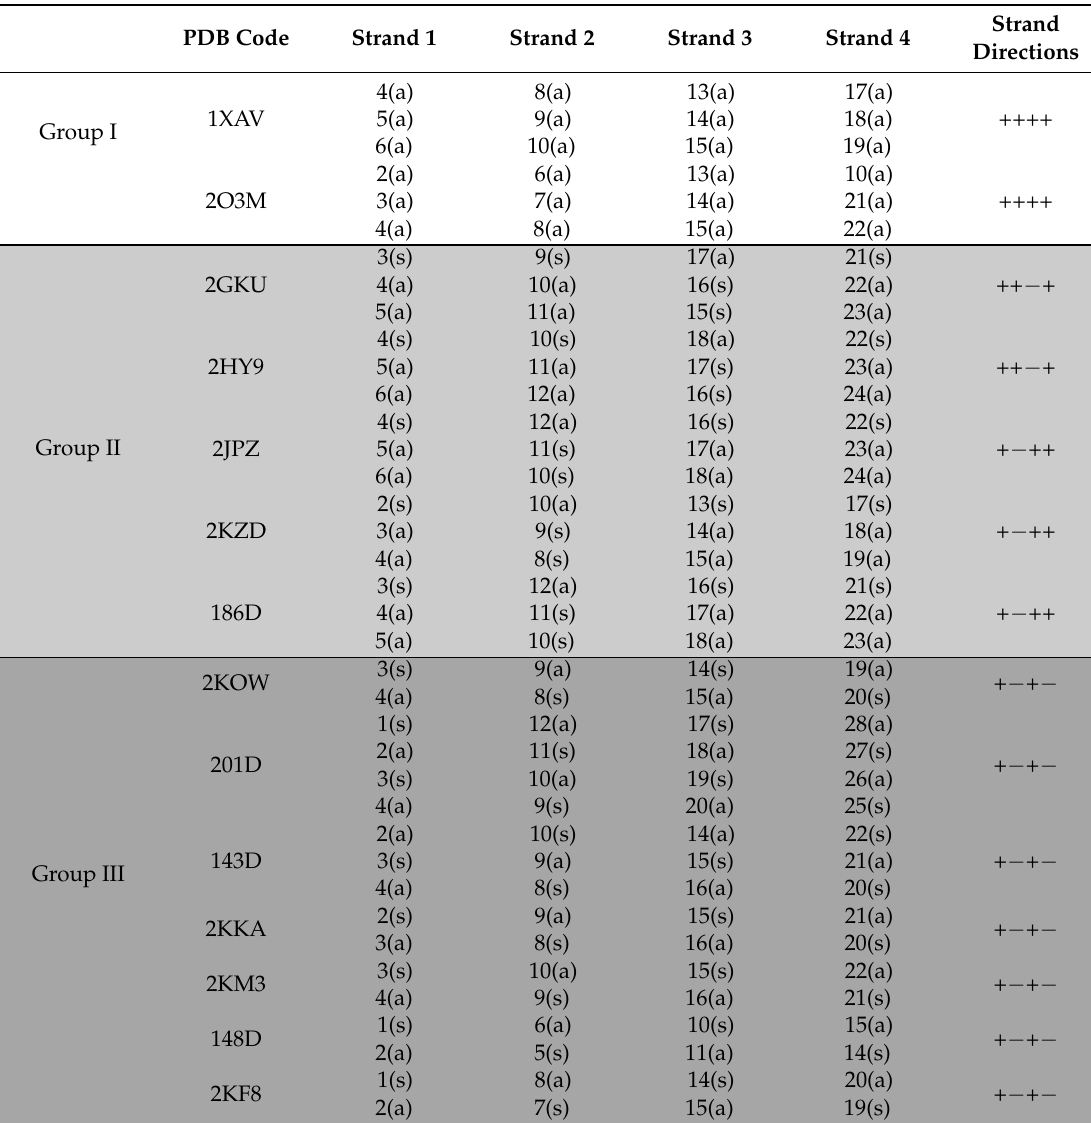
Table 4. GBA sequence in the selected structures.